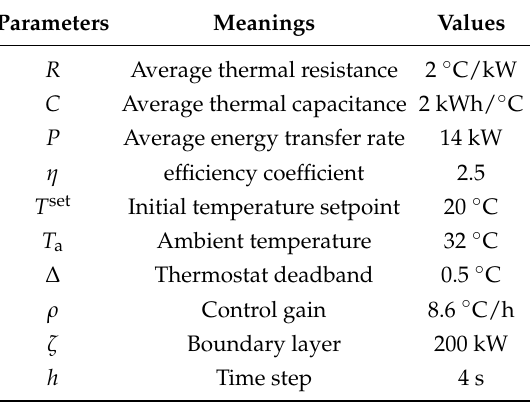
Table 1. Parameter